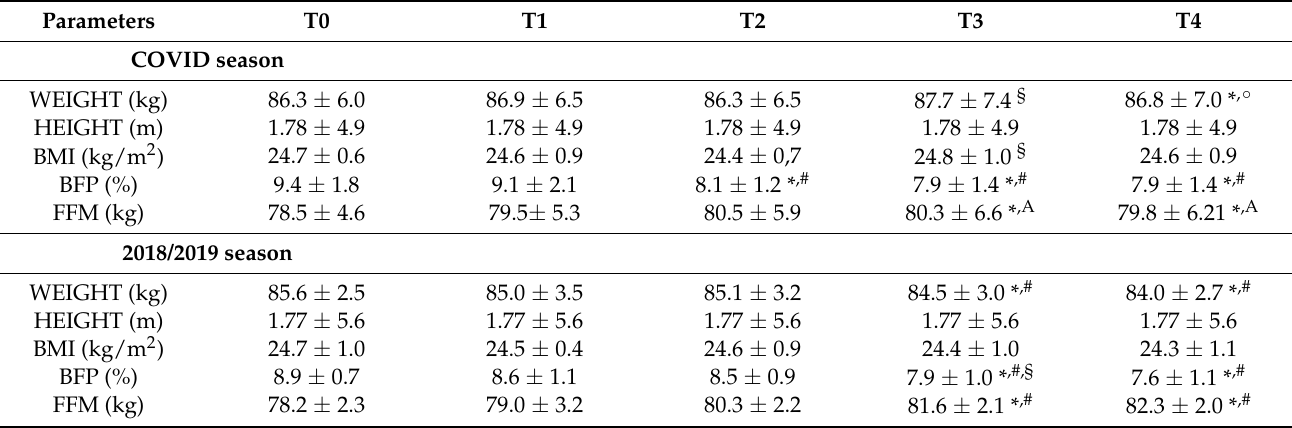
Table 2. Anthropometric characteristics of football players during different times during